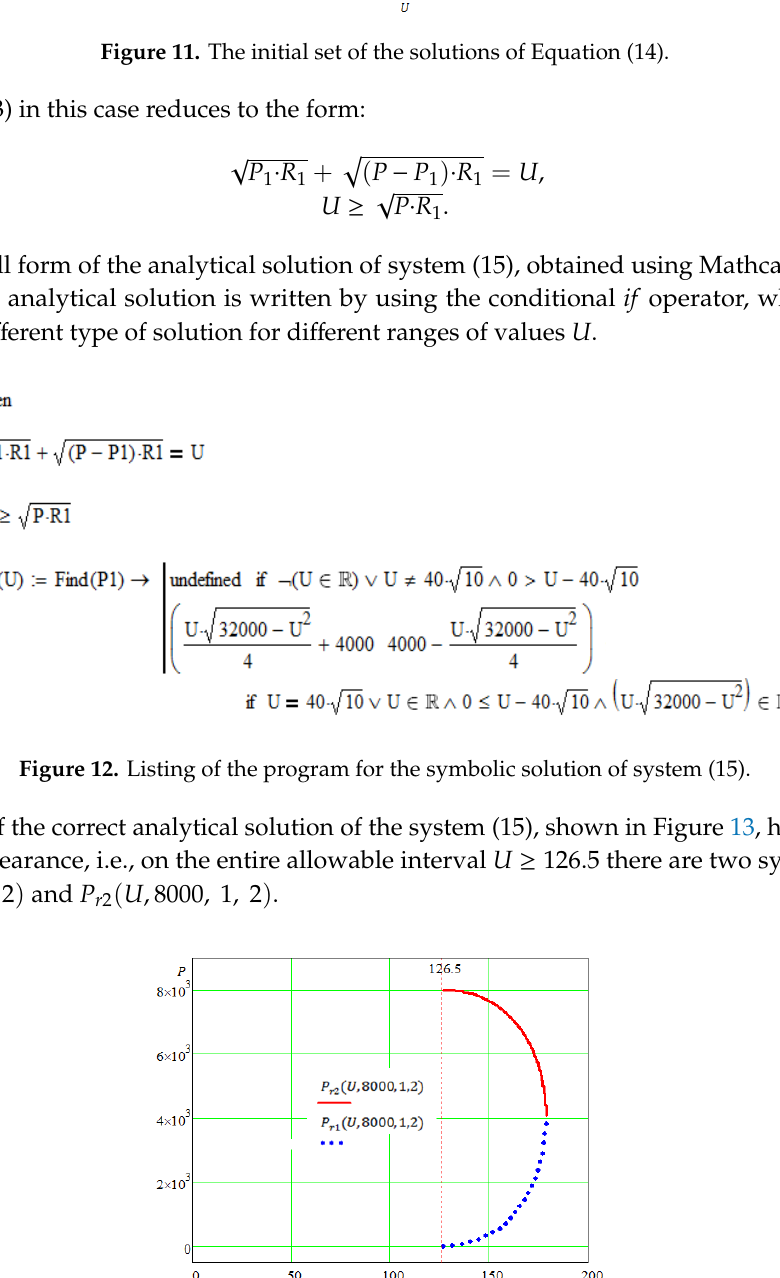
Figure 13. Set of the correct solutions of system (15).